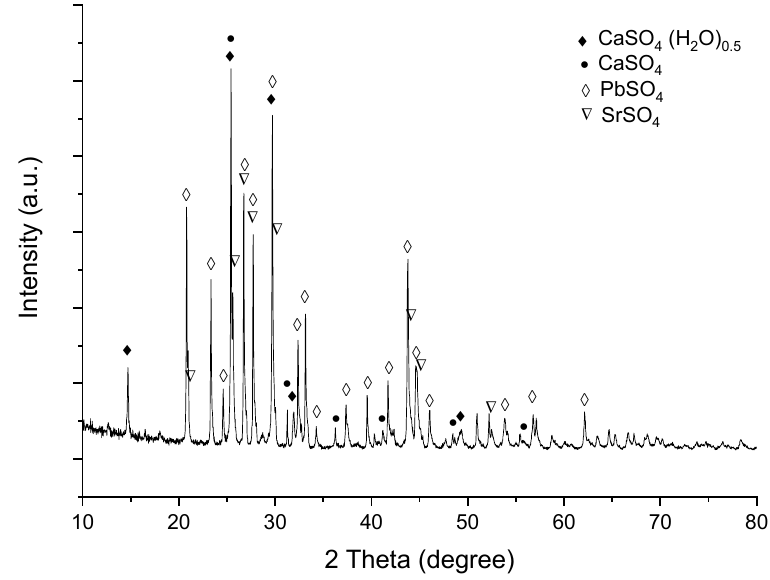
Figure 13. XRD pattern of leaching residue.